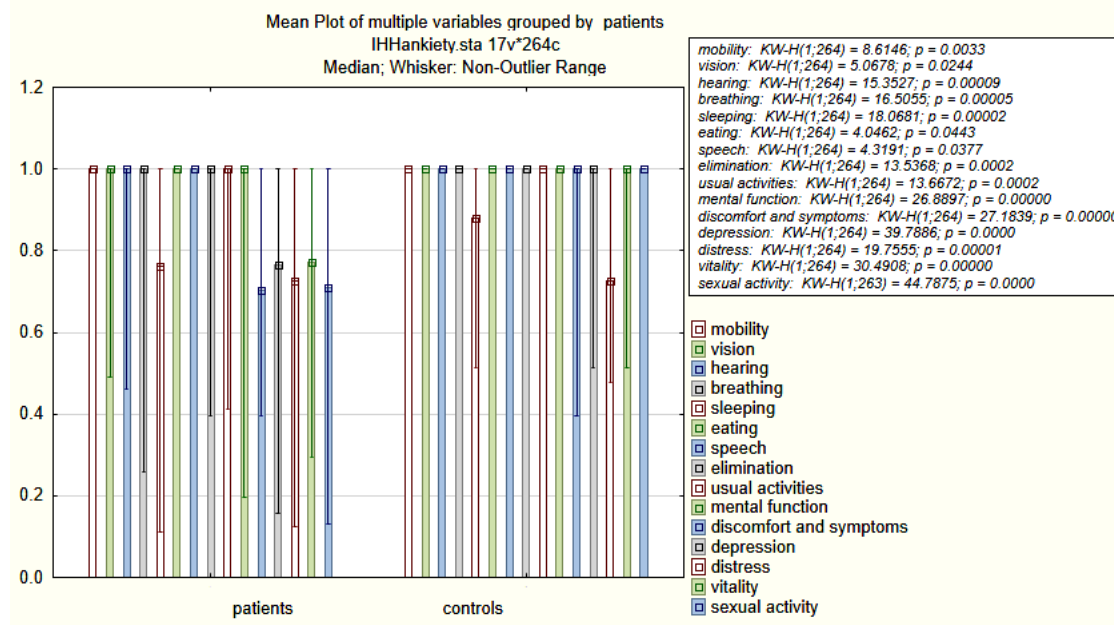
Figure 2. Median (IQR) values of 15D dimensions in IHH patients and the control group. Table 2. Scores from the 15D instrument (15D), the Zung Self-Rating Depression Scale (SDS), the Sexual Satisfaction Questionnaire (SSQ), and the 5-item International Index of Erectile Function (IIEF-5)—data from patients with isolated hypogonadotropic hypogonadism (IHH) and controls.